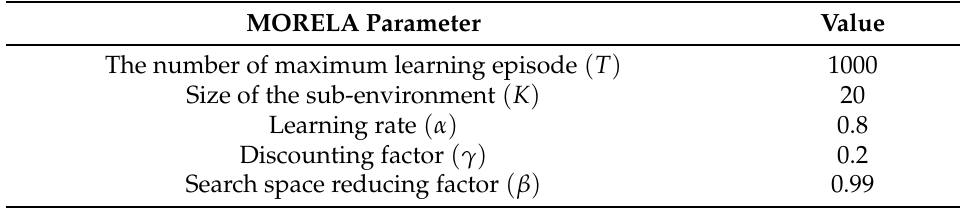
Table 2. MORELA parameter